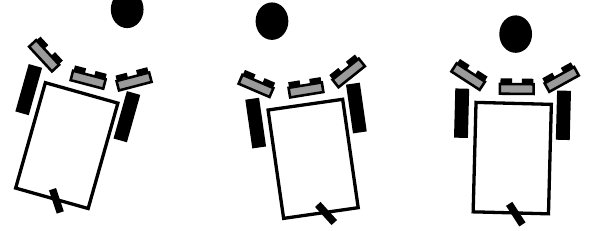
Figure 6. Scheme of the network training activity by moving the position of the object relative to the rover. Table 2. Acquired dataset distribution for neural network